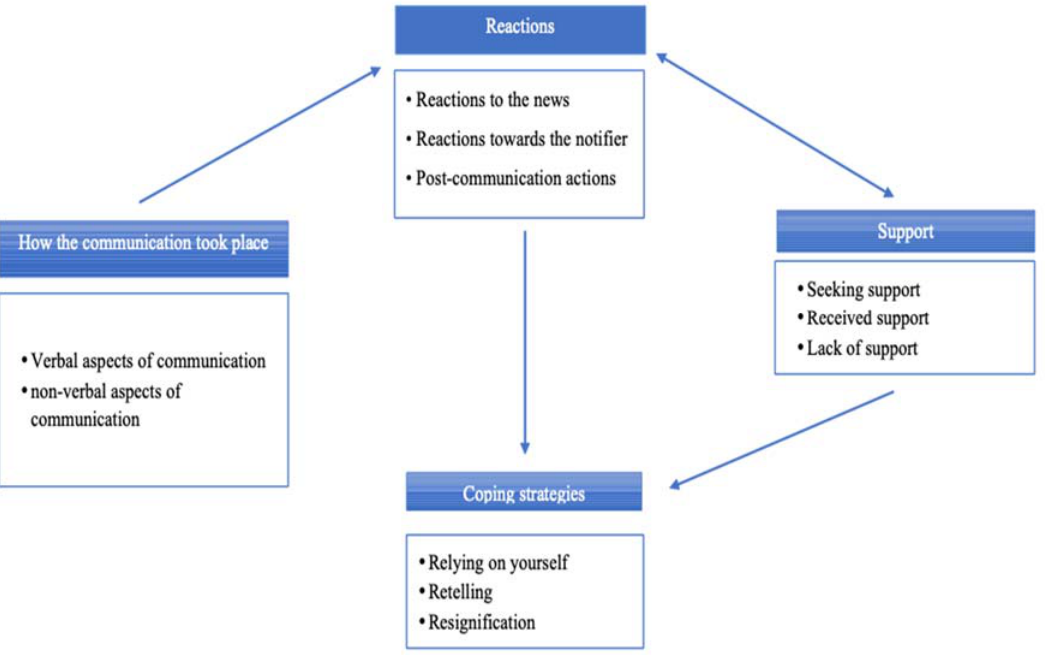
Figure 1. Roadmap of interactions among the main themes.